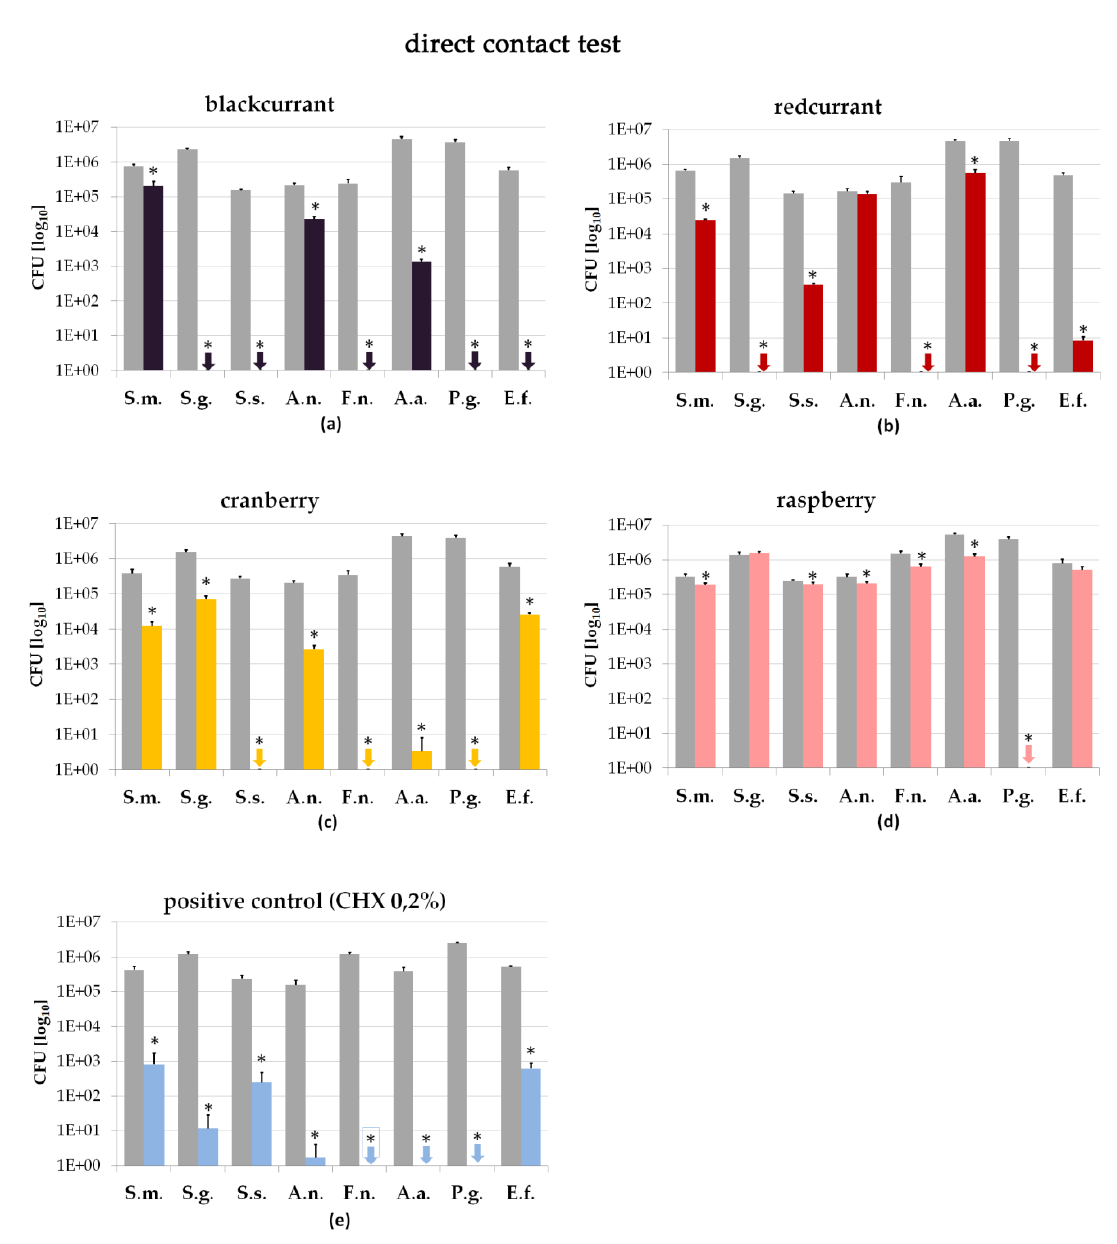
Figure 2. The results of the direct contact test are shown (juice concentration 90% / incubation time 60 s); gray column represents negative control (nutrition media); black column represents test agent in direct contact for 60 s; * asterisk indicates significant differences ( p < 0.05) from the negative control. ( a ) Blackcurrant; ( b ) redcurrant; ( c ) granberry; ( d ) raspberry; ( e ) positive control (0.2% CHX) ( Streptococcus mutans -S.m.; Streptococcus gordonii -S.g.; Streptococcus sobrinus -S.s.; Actinomyces naeslundii -A.n.; Fusobacterium nucleatum -F.n.; Aggregatibacter